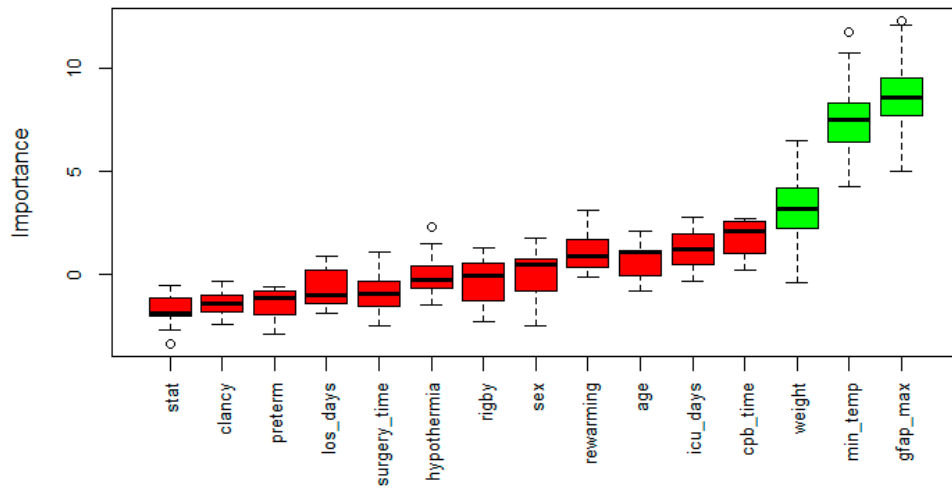
Figure 3. Variable importance for impaired and normal NDI classification. A random-forest-based feature selection method (Boruta) was implemented to obtain the most important variables able to classify patients for their NDI. Green boxes depict the obtained three significant ( p < 0.01) variables. los : length of stay, icu : intensive care unit, cpb : cardiopulmonary bypass. Dots represents outlier values defined as above the third quartile +1.5x interquartile range.